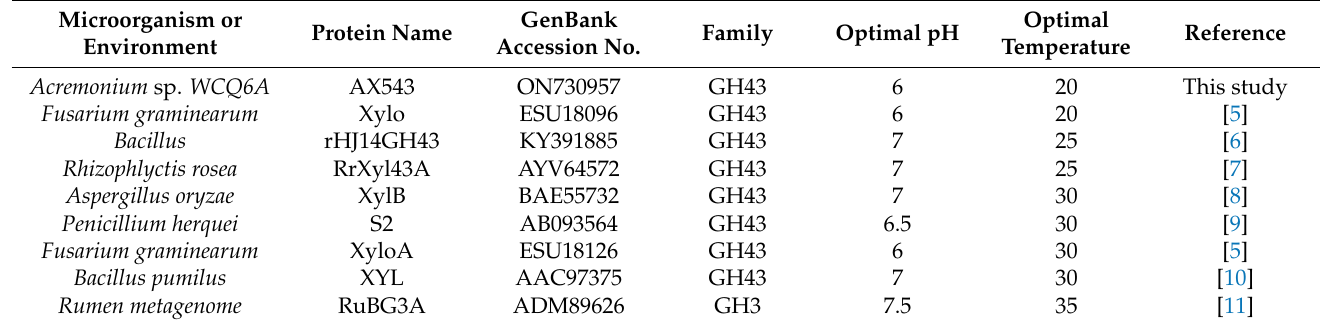
Table 1. Enzymatic properties of the reported psychrophilic